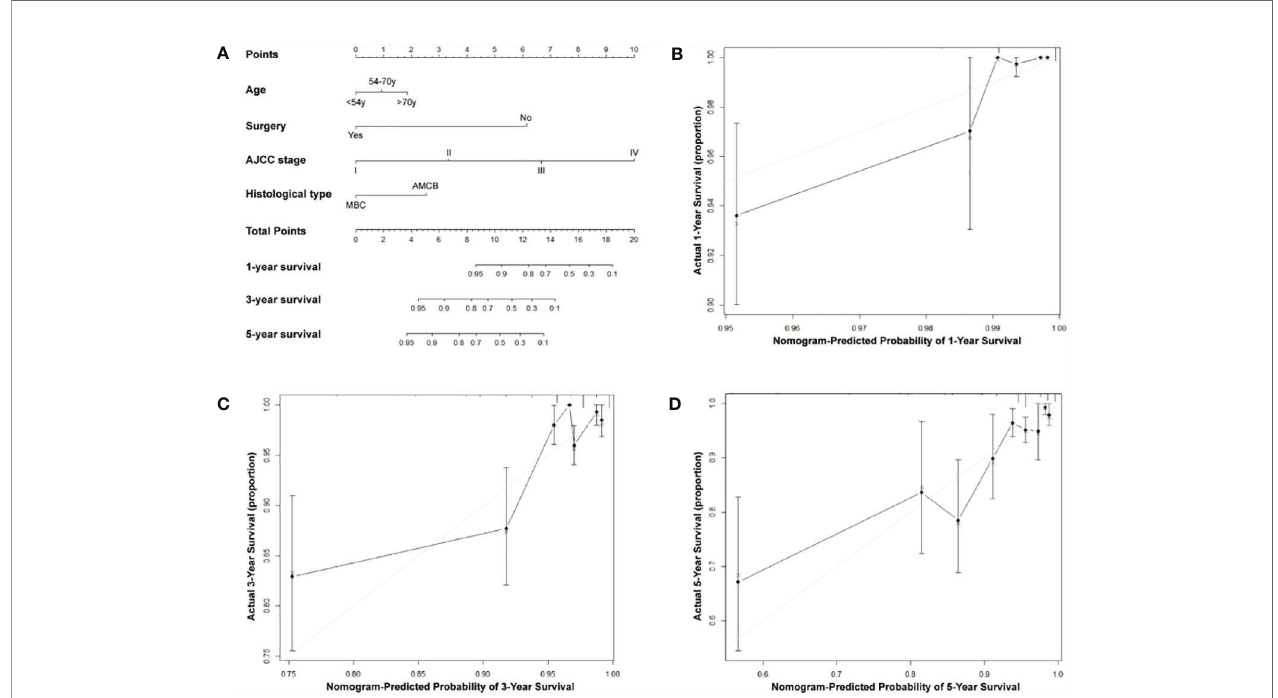
FIGURE 4 | Predictive nomogram assessed by clinical characteristics for 1-, 3-, and 5-year overall survival in MBC and AMCB patients who were HR-negative. (A) The probability of 1-, 3-, or 5-year overall survival was estimated by connecting the probability scale to the total point scale through a vertical line. The calibration curves for overall survival at 1 year (B) , 3 years (C) , and 5 years (D) are